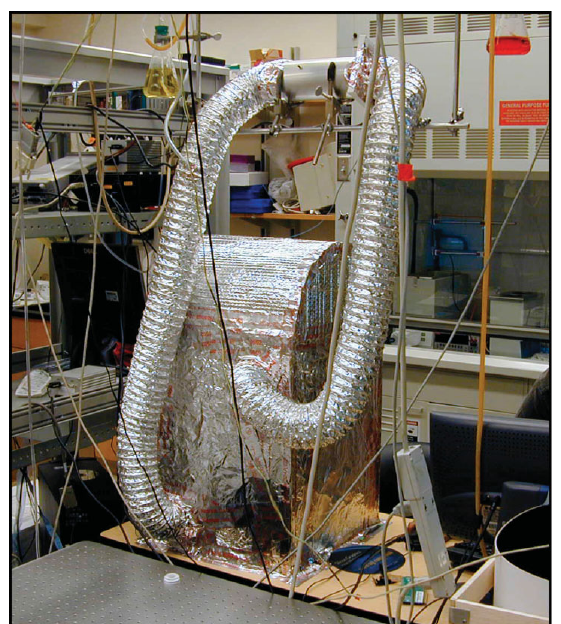
Figure 4. Life-support system for MEART’s brain . The microscope used for observing neural cultures in long-term experiments was wrapped in insulation and outfitted with systems for control of temperature and carbon dioxide levels to maintain normal cell culturing conditions.